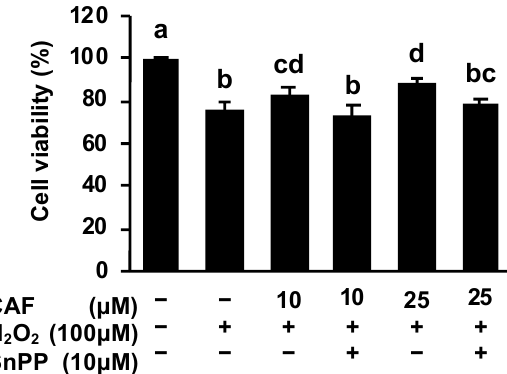
Figure 4. Tin protoporphyrin IX (SnPP), the representative HO-1 inhibitor, impaired the CAF-induced cytoprotection against hydrogen peroxide in Hepa1c1c7 cells. Cells were pretreated with SnPP for 1 h, followed by a 24-h incubation with CAF, then hydrogen peroxide exposure for 6 h. Cell viability was measured using a MTT assay. Values were means ± SD of three independent experiments. The different letters above the bars indicated significant differences among the treatments for each condition ( p < 0.05).